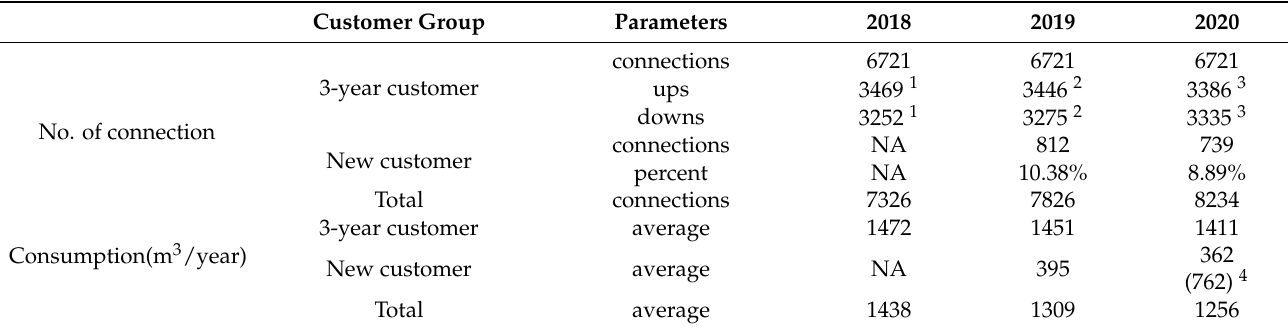
Table 3. The number of connections and water consumption of the nationals in Khalifa City in 2018–2020. Customer